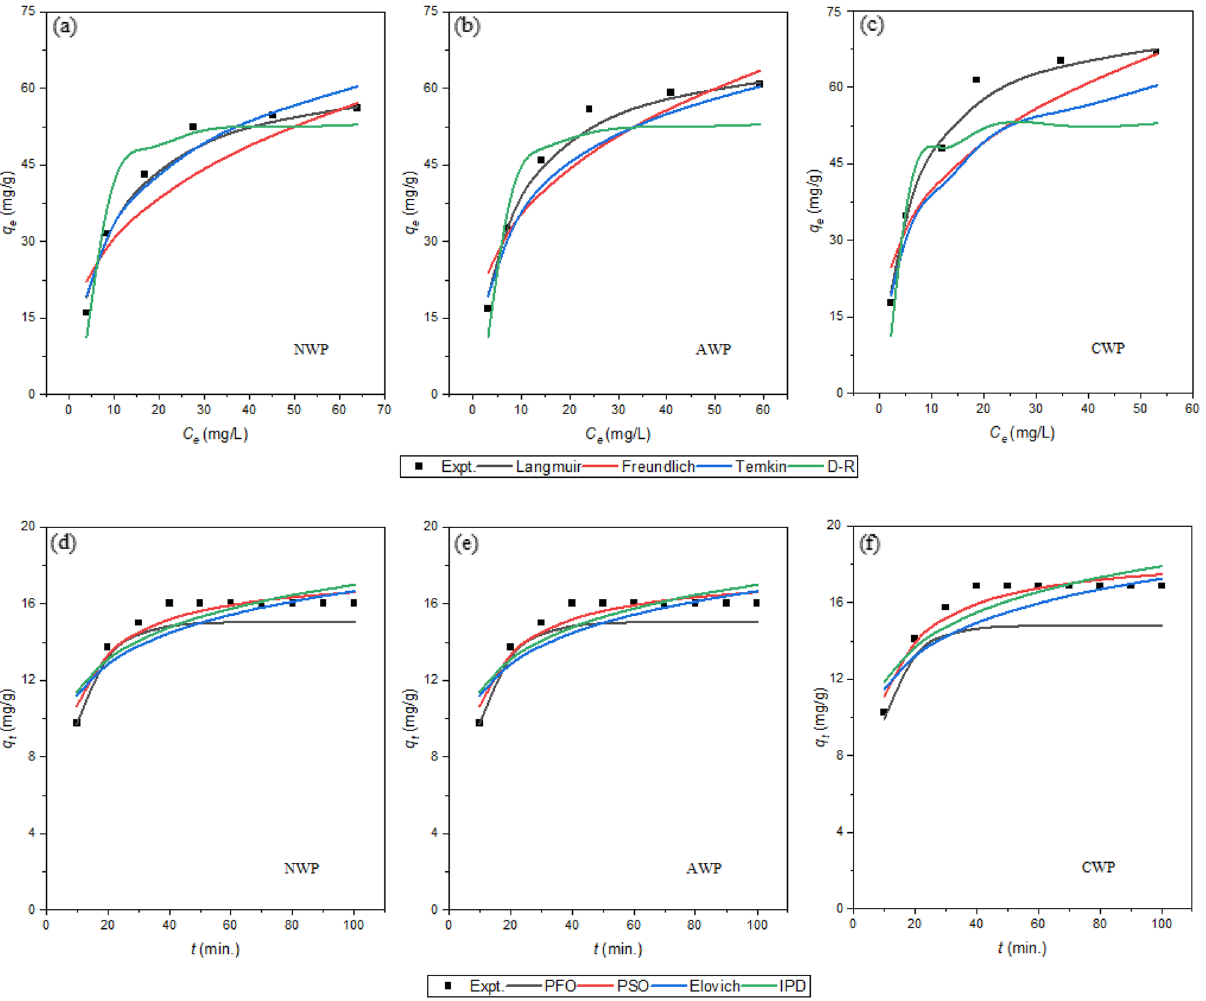
Figure 5. Comparison of experimental and calculated values of q e and q t after non-linear regression analysis of isotherms and kinetic models, respectively, for adsorption of Cr(VI) onto